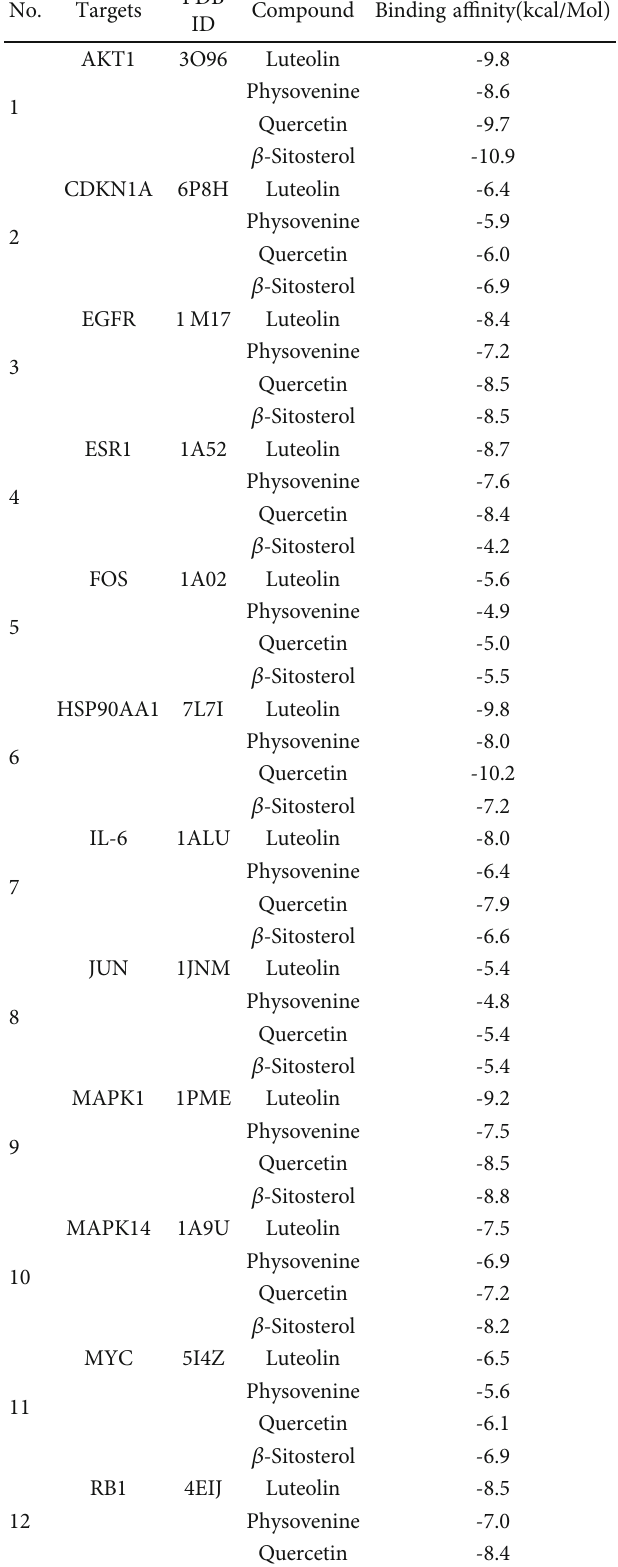
Table 4: Results of 15 core target genes and related bioactive compounds of molecular docking.